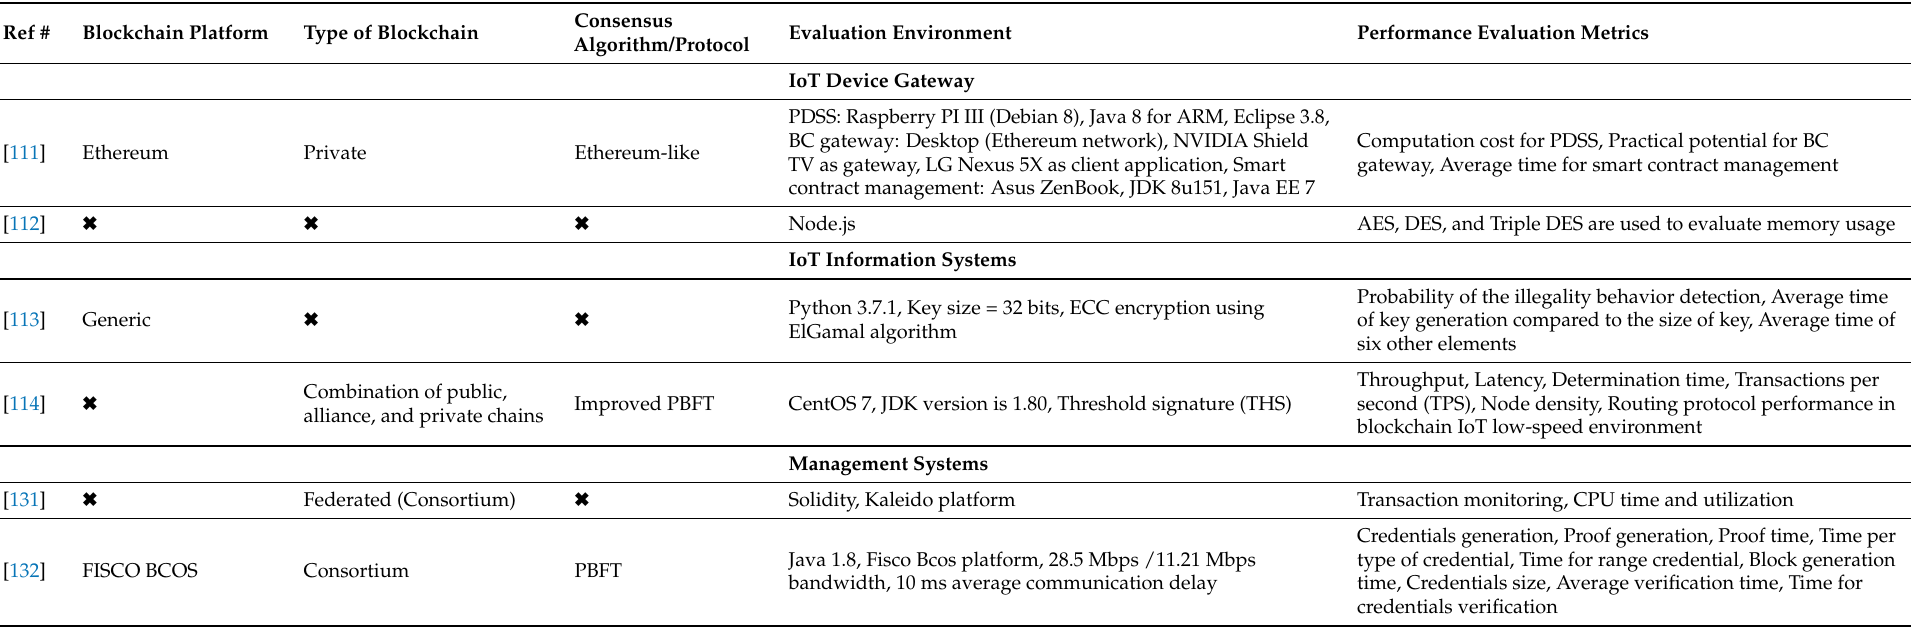
Table 6. IoT Device Gateway, IoT Information Systems, and Management Systems Articles: Blockchain Characteristics, Evaluation Environment, and